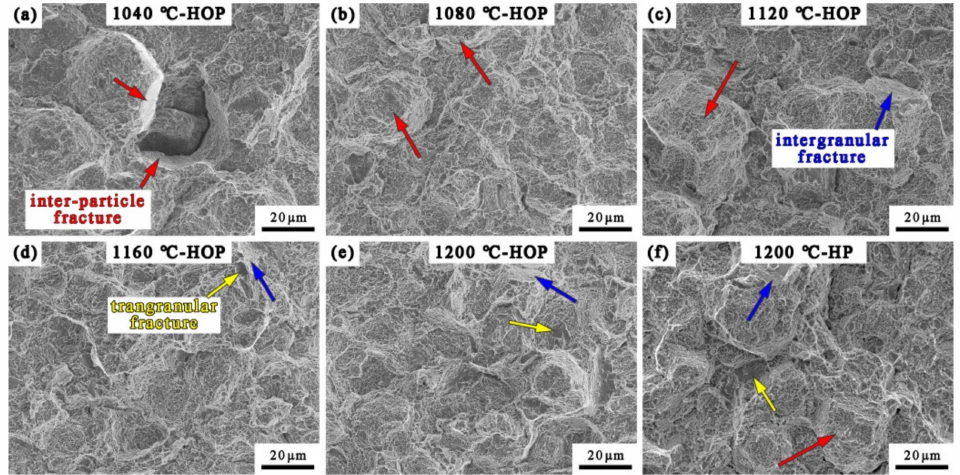
Figure 9. Fracture surfaces of the HOPed and HPed samples: ( a ) 1040 ◦ C-HOP; ( b ) 1080 ◦ C-HOP; ( c ) 1120 ◦ C-HOP; ( d ) 1160 ◦ C-HOP; ( e ) 1200 ◦ C-HOP; ( f ) 1200 ◦ C-HP.